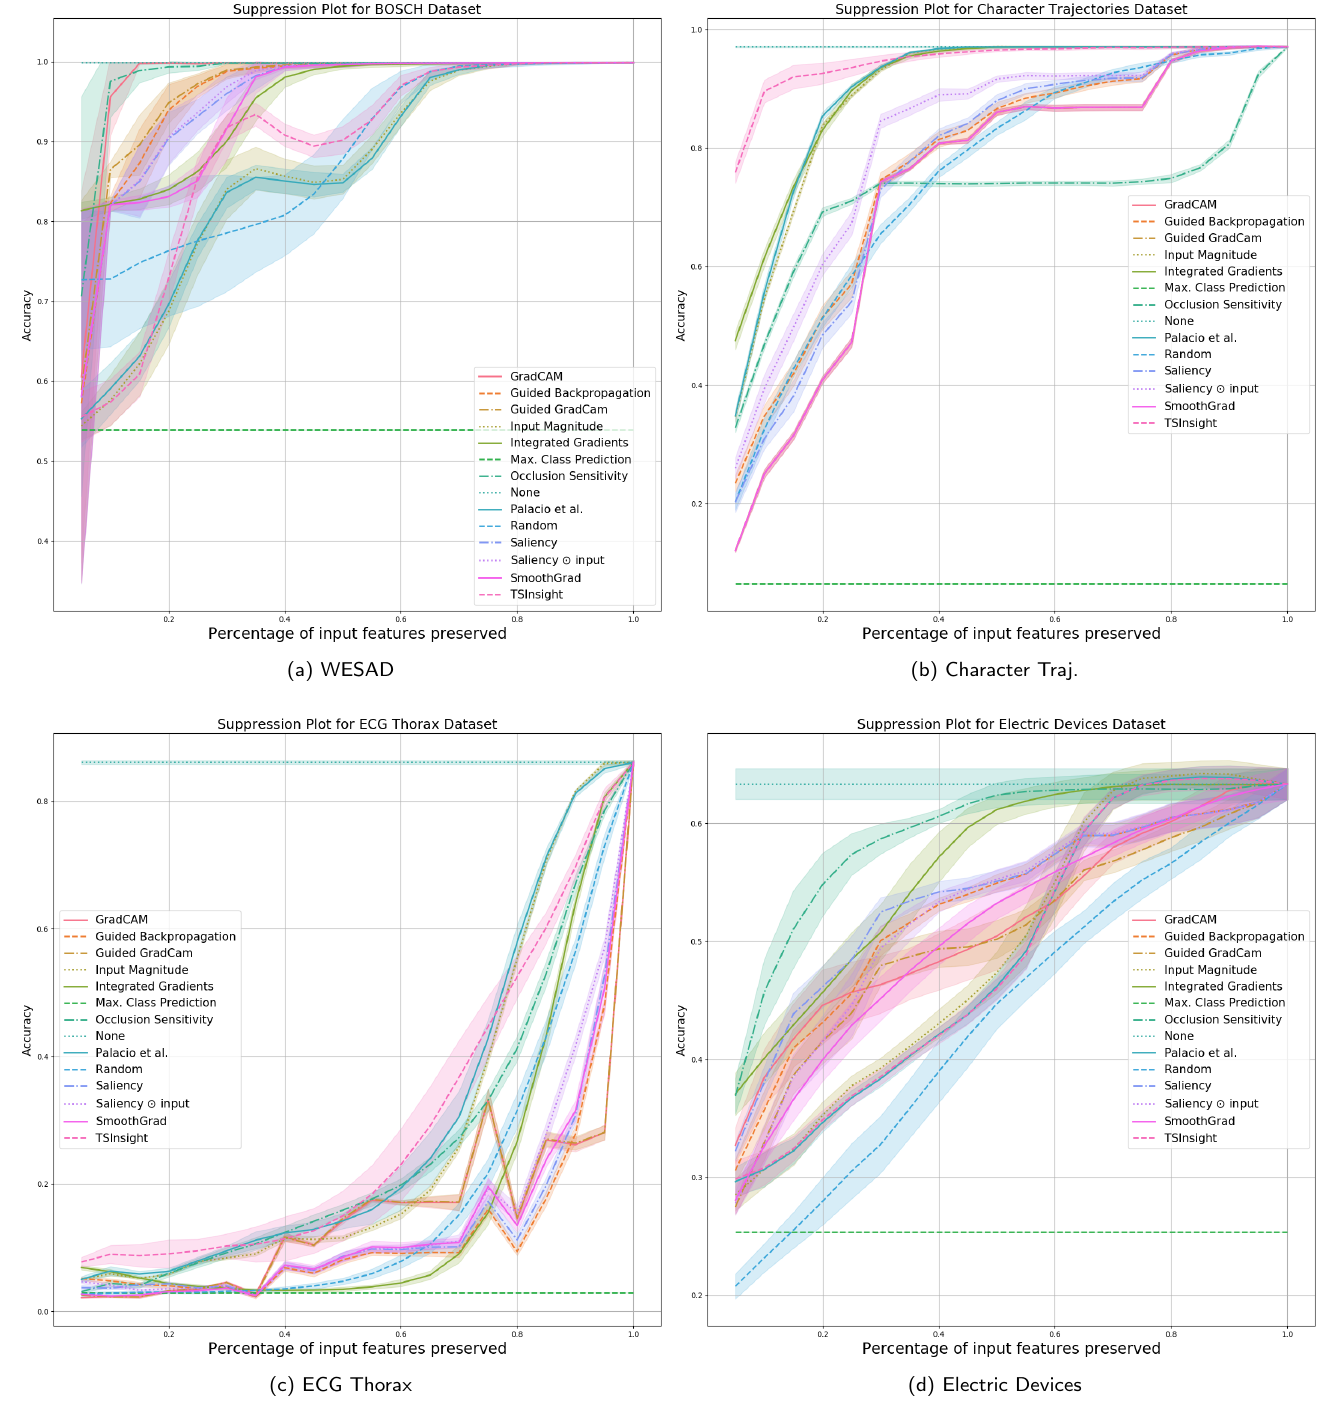
Figure 3. Suppression results (1/2) against a large number of baseline methods computed using 5 random runs (best viewed